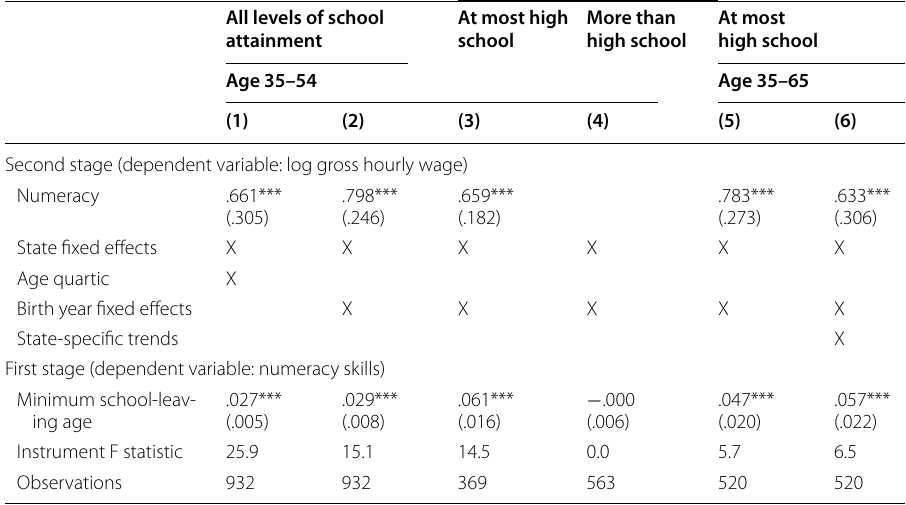
Two-stage least squares regressions weighted by sampling weights. Sample: full-time employees in the United States. Second-stage coefficient is not displayed if the first-stage coefficient is insignificant. All regressions control for gender. Robust standard errors (adjusted for clustering at state level) in parentheses. Significance levels: * p < 0.10, ** p < 0.05, *** p < 0.01